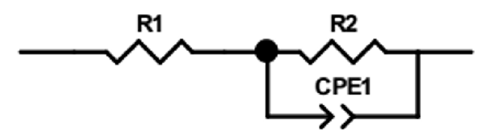
Figure 3. Electric circuit used to simulate the EIS results.